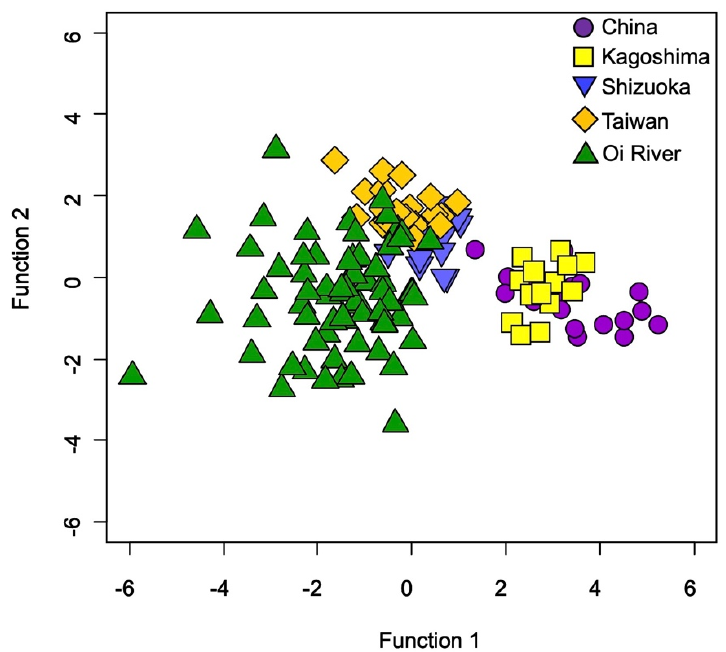
Figure 5. Quadratic discriminant function analysis among five locations in a wild habitat (Oi River) and four aquaculture farms (China, Kagoshima Prefecture of Japan, Shizuoka Prefecture of Japan, and Taiwan) based on all the otolith elemental ratios (Na:Ca, Mg:Ca, P:Ca, K:Ca, Sr:Ca, and Ba:Ca) in the Japanese eel ( Anguilla japonica ).